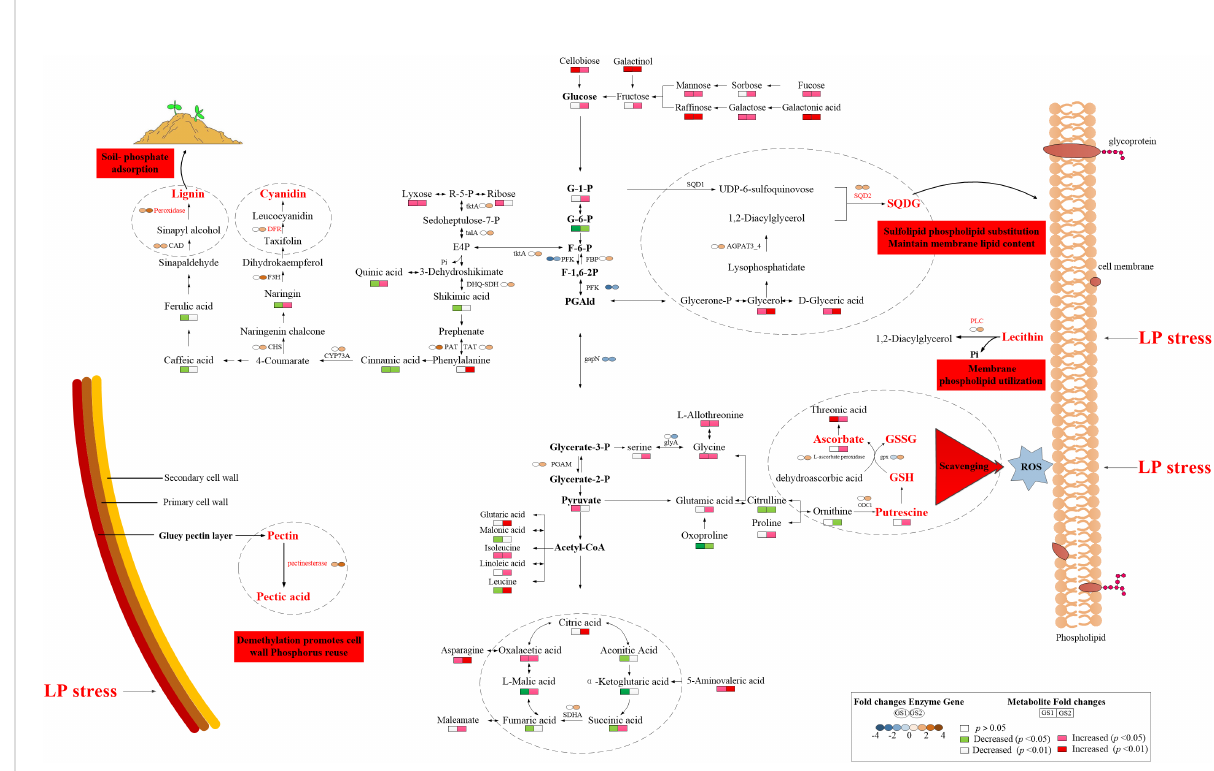
FIGURE 5 Key mechanisms of resistance to phosphorus de fi ciency in wild soybean. GS1, common wild soybean; GS2, barren-tolerant wild soybean; AGPAT3_4, lysophosphatidic acid acyltransferase; CAD, cinnamyl-alcohol dehydrogenase; CHS, chalcone synthase; CYP73A, trans-cinnamate 4-monooxygenase; DFR, bifunctional dihydro fl avonol 4-reductase/ fl avanone 4-reductase; DHQ-SDH, 3-dehydroquinate dehydratase/shikimate dehydrogenase; F3H, naringenin 3-dioxygenase; FBP, fructose-1,6-bisphosphatase; gapN, glyceraldehyde-3-phosphate dehydrogenase (NADP + ); glyA, glycine hydroxymethyltransferase; gpx, glutathione peroxidase; GSH, glutathione; GSSG, glutathione disul fi de; ODC1, ornithine decarboxylase; PAT, aspartate-prephenate aminotransferase; PFK, 6-phosphofructokinase; PGAM, 2,3-bisphosphoglycerate-dependent phosphoglycerate mutase; PLC, phospholipase C; SDHA, succinic dehydrogenase, SQD2, sulfoquinovosyltransferase; talA, transaldolase; TAT, tyrosine aminotransferase; tktA,